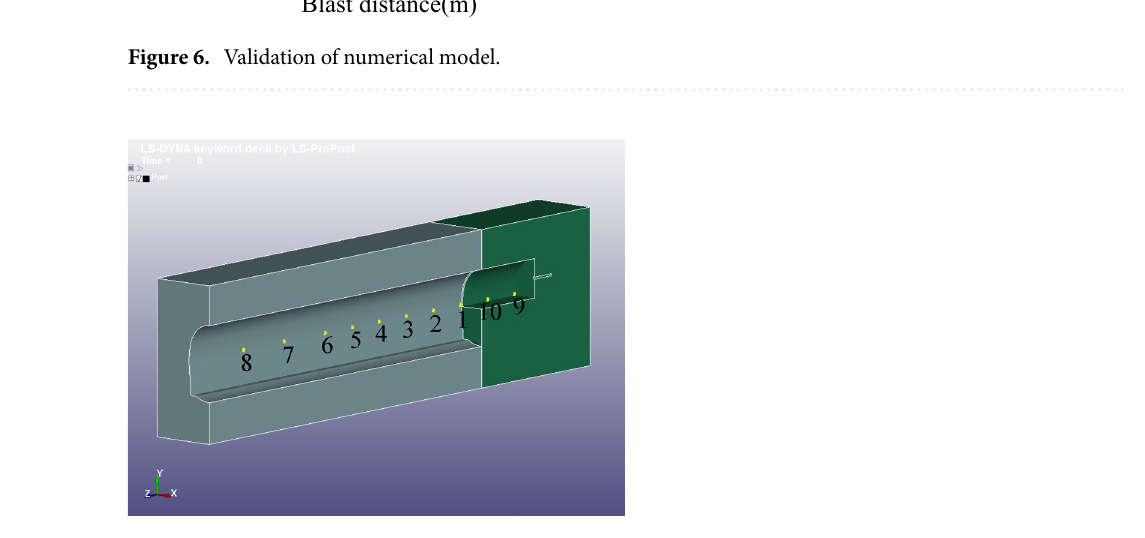
Figure 7. Illustration of monitoring point